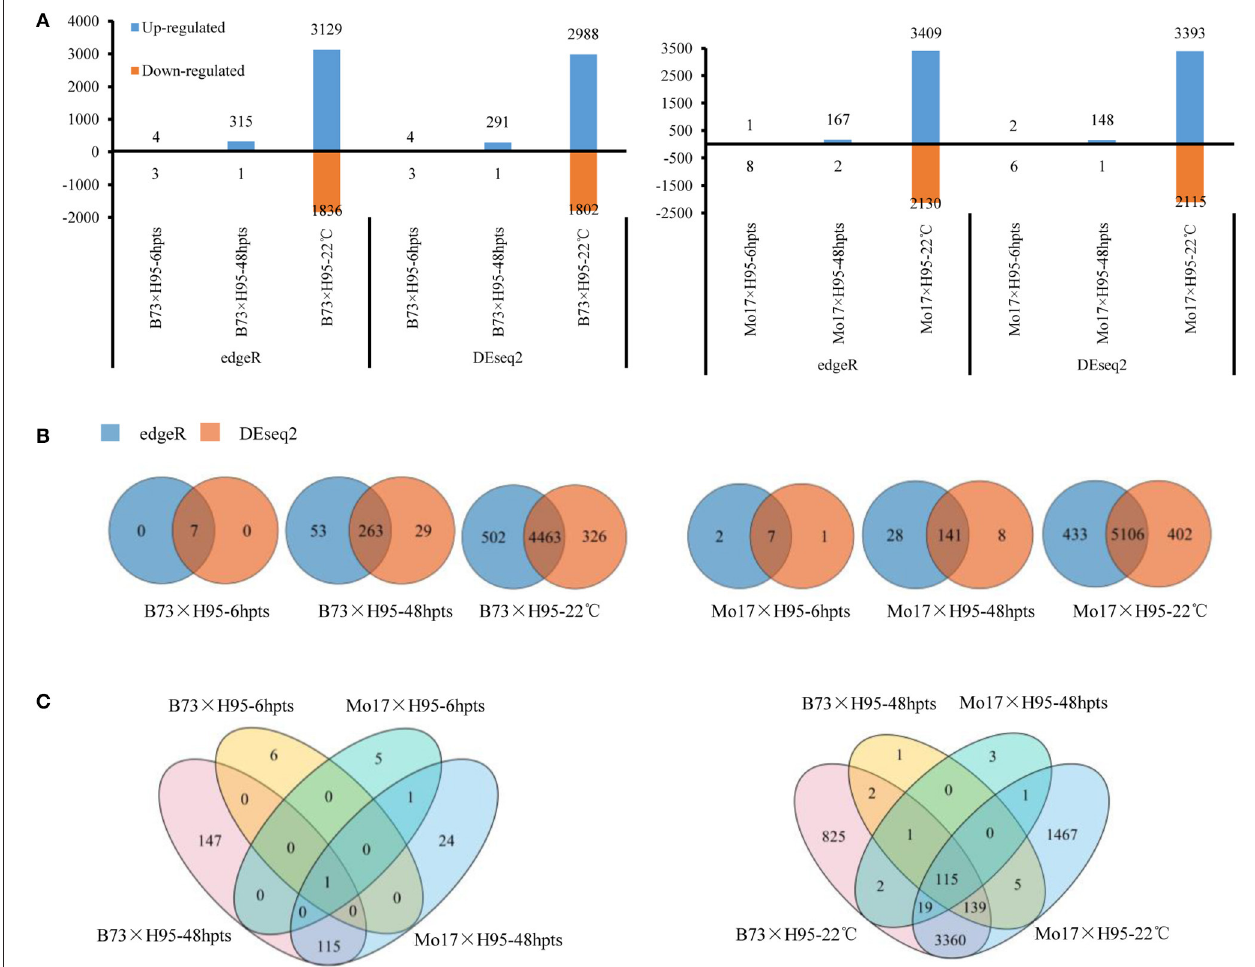
FIGURE 1 | Differentially expressed genes (DEGs) in Rp1-D21 mutant (mt) compared to the wild type (WT) in B73 × H95 and Mo17 × H95 backgrounds. (A) The up and downregulated DEGs in B73 × H95 and Mo17 × H95 backgrounds as calculated by edgeR and DEseq2. (B) Numbers of DEGs from edgeR and DEseq2 methods at different treatments. Venn diagrams of DEGs among different time points and temperature treatments from both edgeR and DEseq2. (C) The common DEGs between both genotypes at 6 and 48h post temperature shift (hpts) (left), and at constant 22 ◦ C (right), respectively.